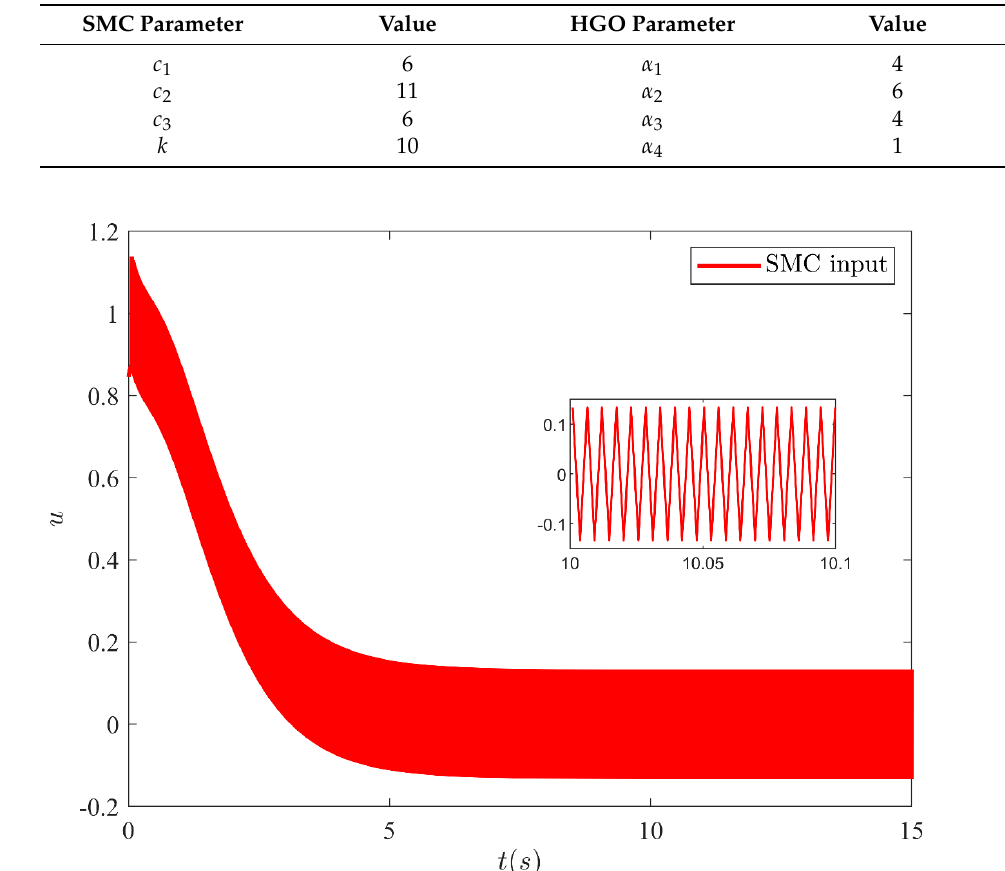
Figure 6. SMC control input with chattering (using signum function). Table 2. SMC and HGO parameters.